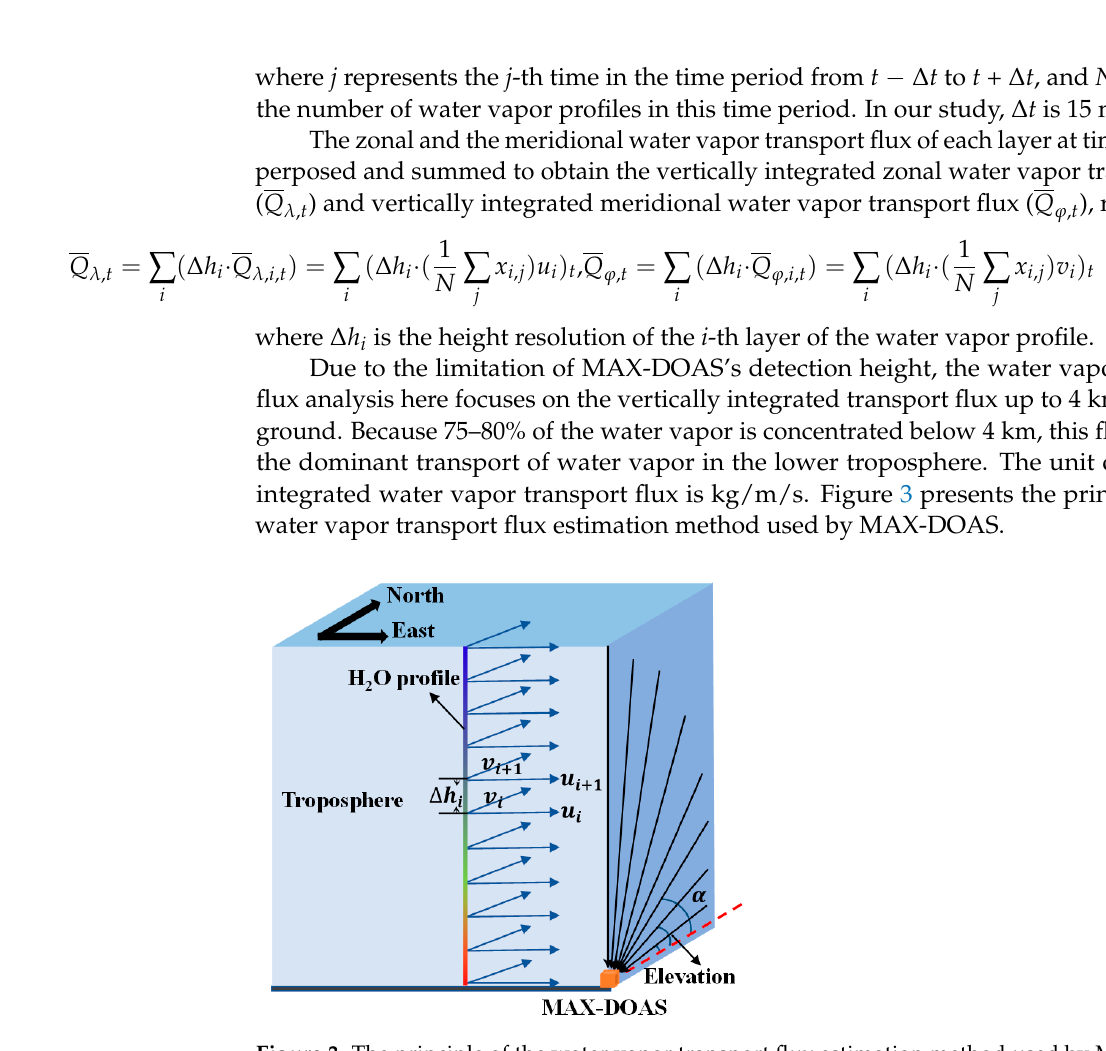
Figure 3. The principle of the water vapor transport flux estimation method used by MAX-DOAS.